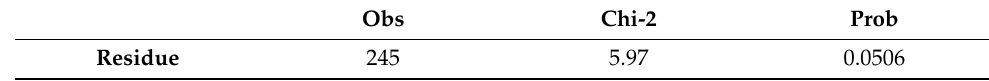
Table 6. Result of the skewness and kurtosis